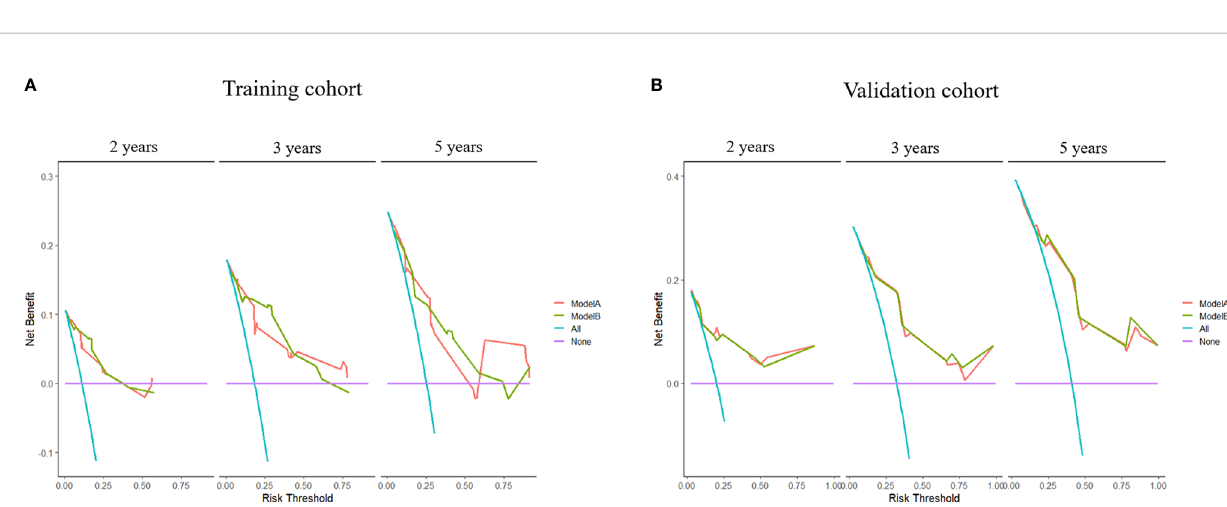
FIGURE 3 | Decision curve analyses (DCA) of models (A, B) at 2, 3, and 5 years after surgery in the training cohort and 2, 3, and 5 years after surgery in the validation